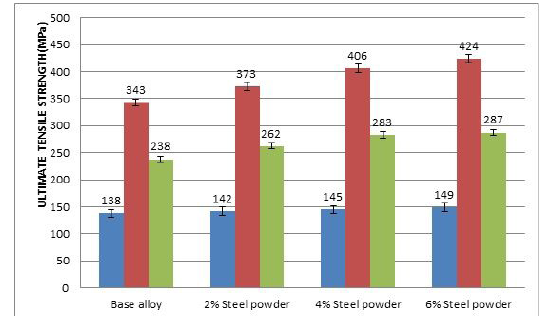
Figure 11. UTS of as cast and peak aged Al 7075 eutectoid steel reinforced composite - Pearlite hybrid